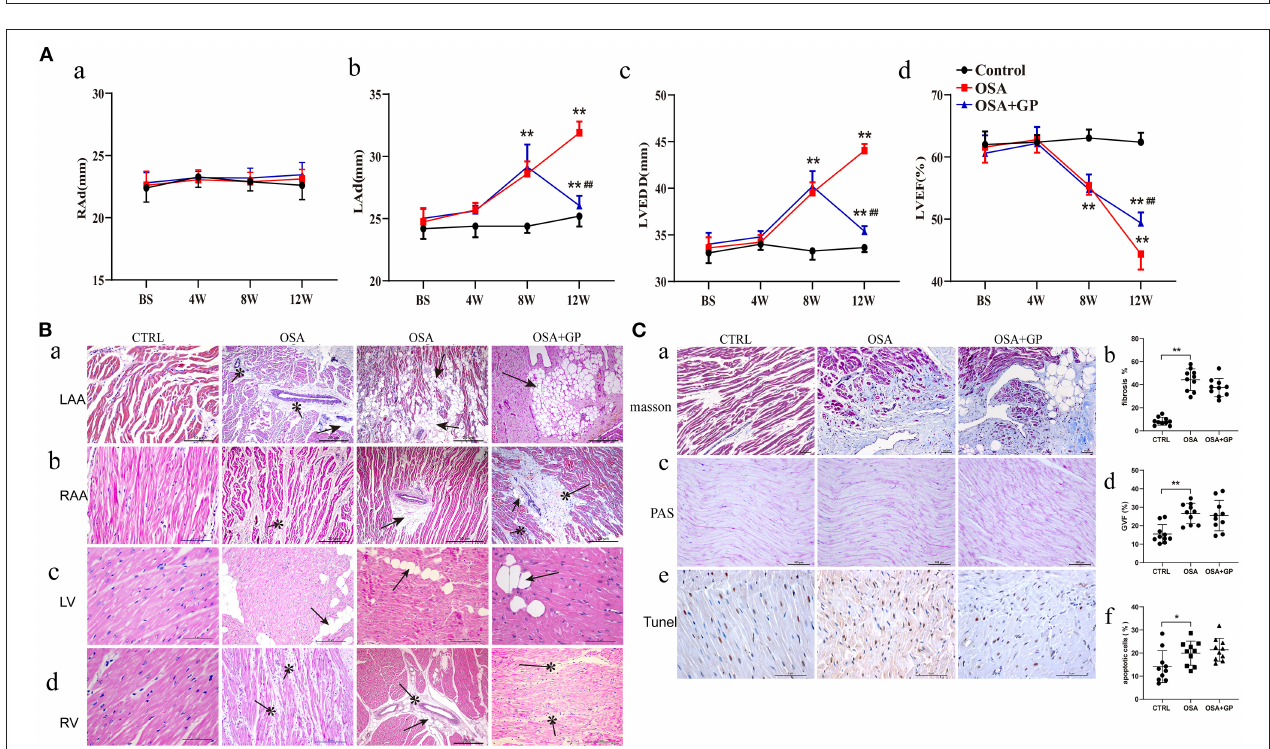
FIGURE 5 | Effect of SLGP ablation on electrical conduction heterogeneity. (A) Representative immunohistochemical staining of Cx43 and Cx40 in LA among the three groups. (B) Quantitative analysis of Cx43- and Cx40-positive cells among the three groups. * P < 0.05, n = 5. Cx43, connexin 43; Cx40, connexin 40; other abbreviations as in Figure 1 .